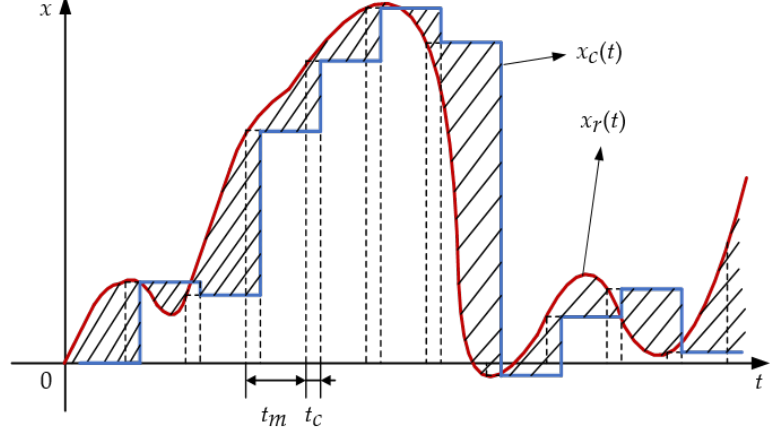
Figure 4 . Effect of gravity update interval and computing time delay on compensation accuracy. Figure 4. Effect of gravity update interval and computing time delay on compensation